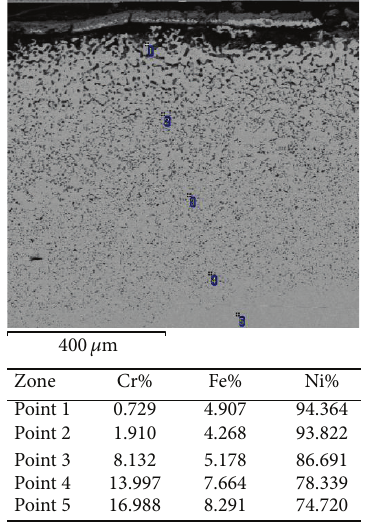
Figure 6: SEM image and EDS analysis of a cross-section of Inconel 600 after corrosion test at 800 ∘ C in NaCl-KCl mixture.